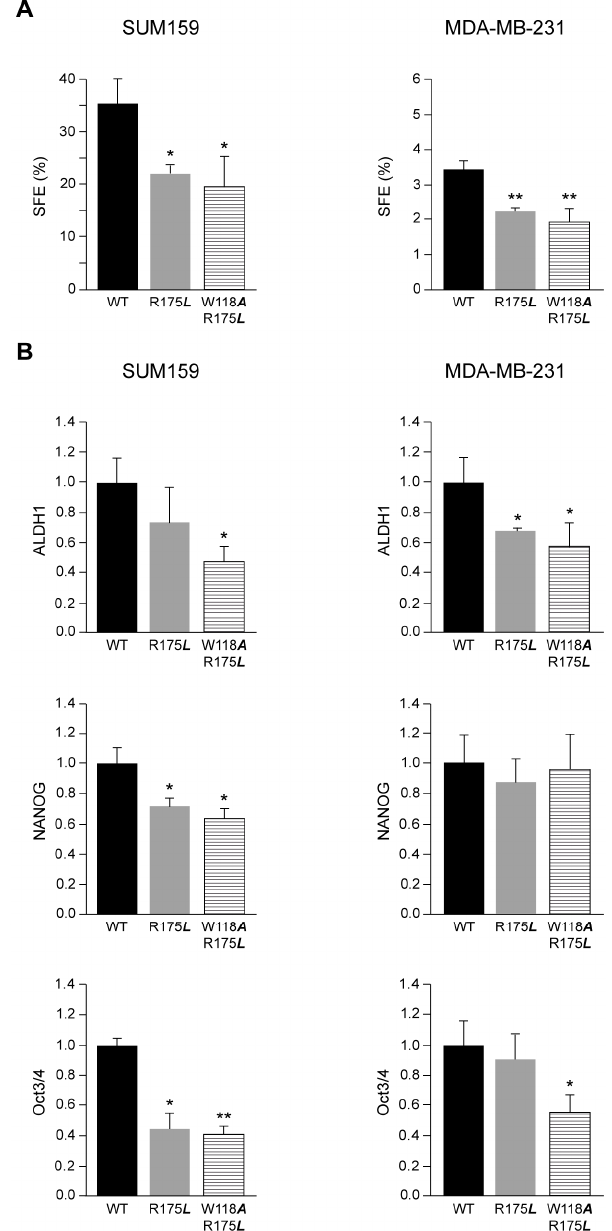
Figure 2. Role of c-Src variants in the self-renewal of breast cancer stem cells (BCSCs) derived from SUM159 and MDA-MB-231. The evaluation of self-renewal was determined by the sphere formation efficiency (SFE) in the enriched subpopulation of BCSCs derived from SUM159 and MDA-MB-231 ( A ). The SFE was measured at the third generation of mammospheres (see Materials and Methods). Each experiment was measured in triplicates ( n = 3) and repeated three times. Results were expressed as a percentage of the mean ± standard deviation (SD). The statistical significance is referred to those obtained from c-Src-wt, * p < 0.5, ** p < 0.01. Quantitative analyses of stem cell markers ALDH1, NANOG, and Oct3/4 expression by WB in SUM159 and MDA-MB-231 cells conditionally expressing c-Src variants ( B ). Results represented data obtained from three independent WB ( n = 3) using β -Actin as a loading control expressed as a percentage of the mean ± SD, and were referred to those obtained from cells expressing c-Src-wt considered as 1. The statistical significance is referred to cells expressing c-Src-wt, * p < 0.5, ** p <